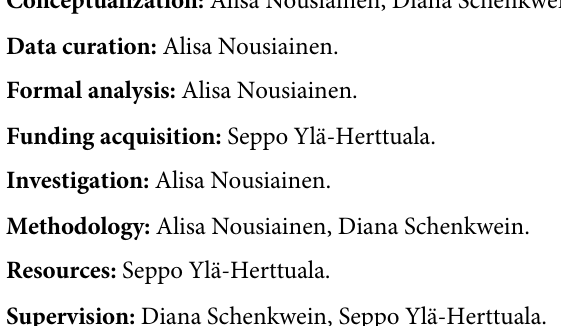
S4 Table. Karyotypes analysed from metaphase chromosomes of LV-transduced CD3+ T lymphocytes on day 4 post-transduction. S5 Table. I-PpoI recognition sites in the human genome. S6 Table. Droplet digital PCR assays used in the study. S7 Table. Programs used in